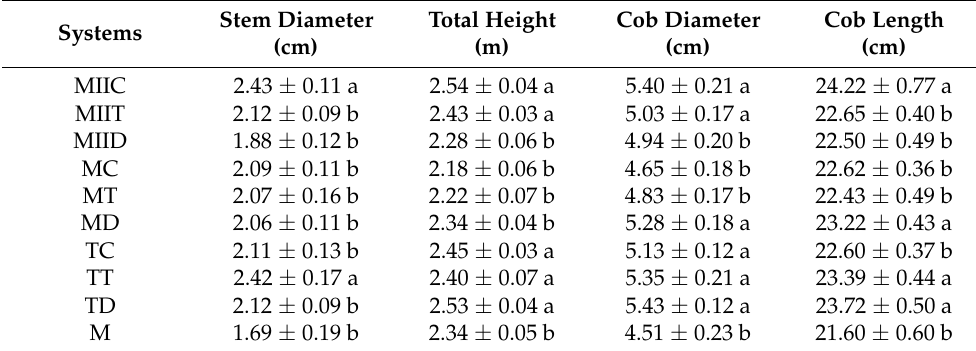
Table 2. Comparison of morphological variables in the evaluated systems.